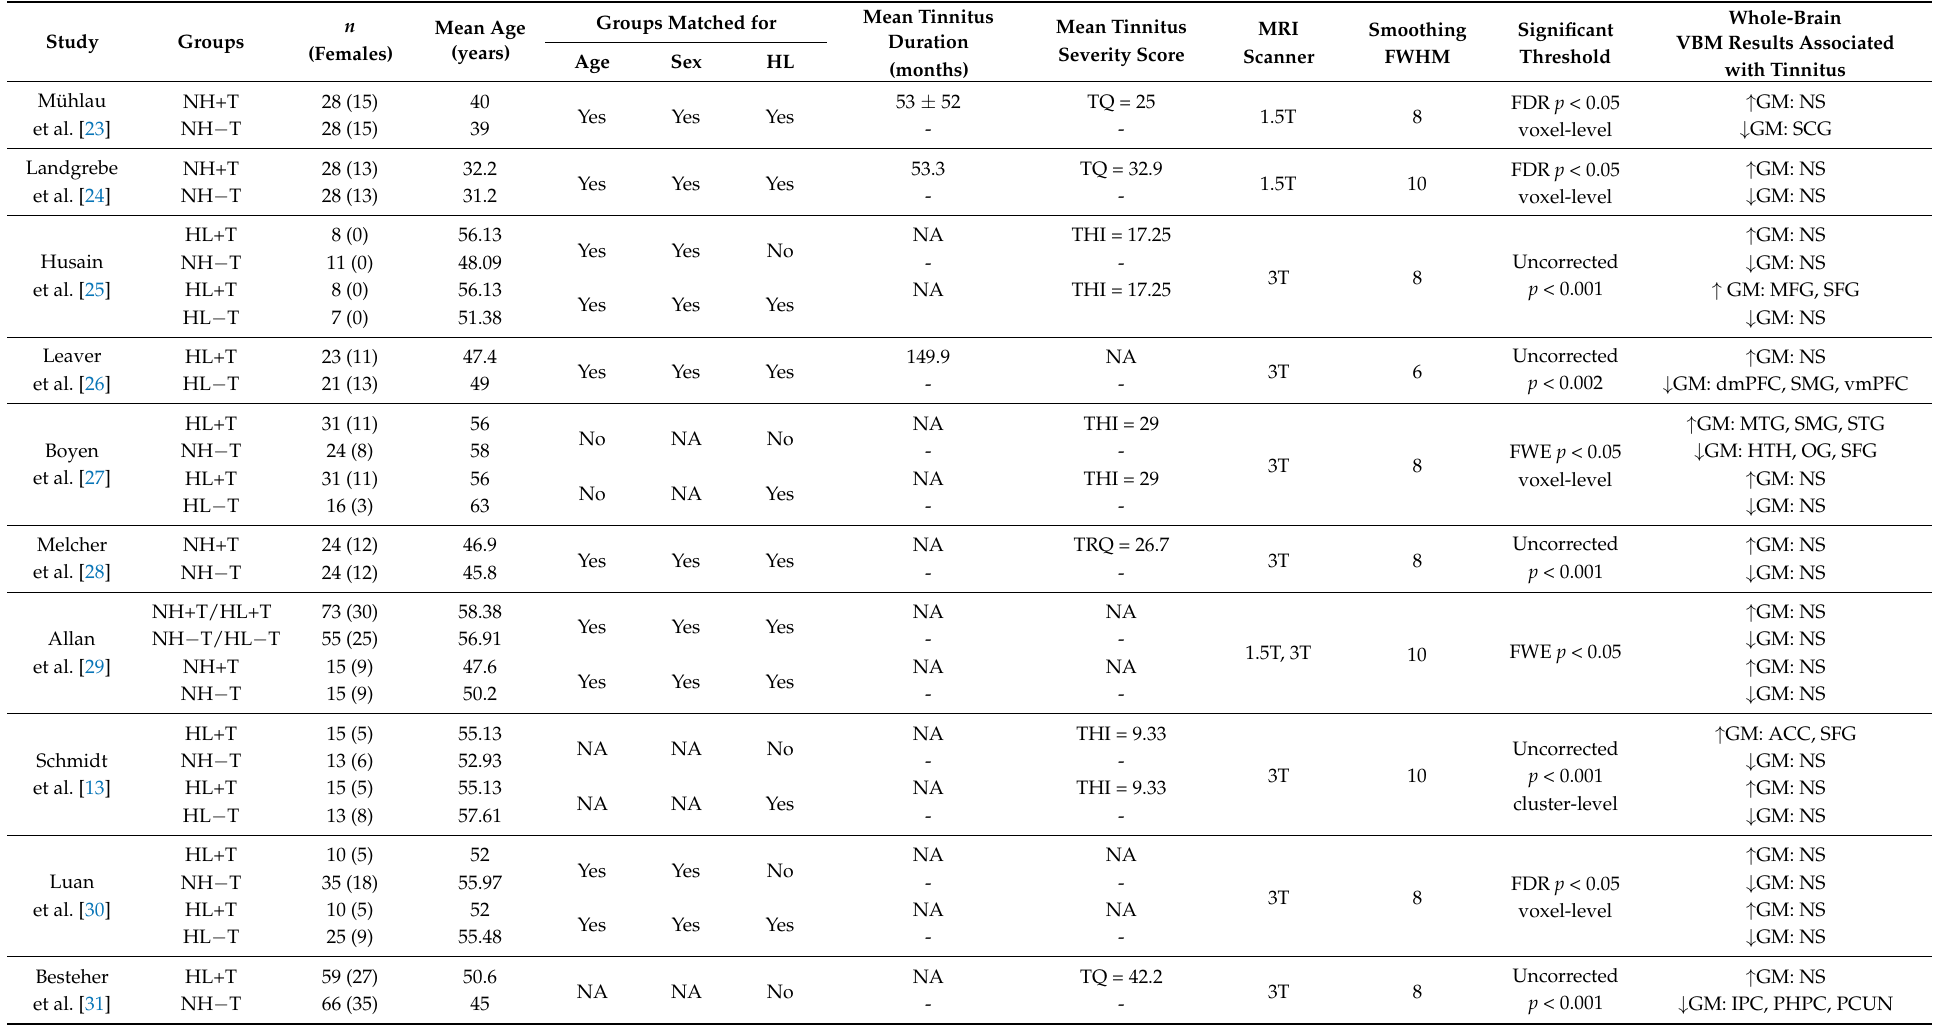
Table 1. Demographic, audiometric, questionnaire, scanning, and methodological information as well as whole-brain VBM results for studies included in the current meta-analysis (see Supplementary Materials S1 for detailed